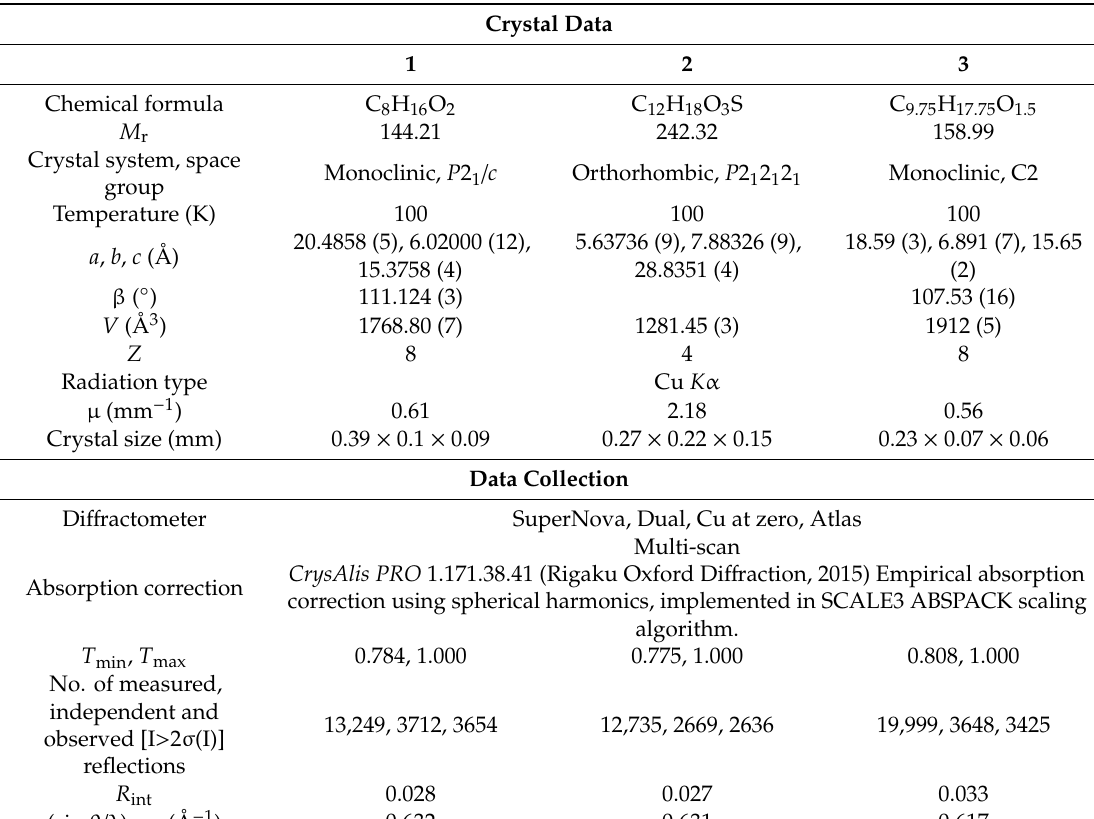
Table 5. Experimental details of precursors 1 , 2 , and 3 . Crystal